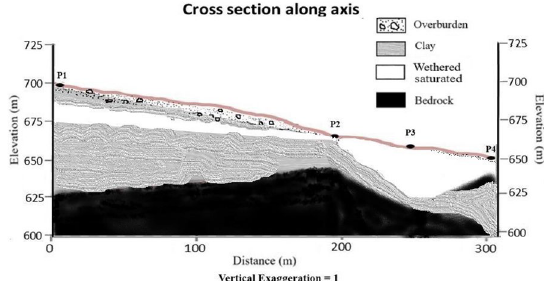
Fig. 8 Interpreted geological profile along survey points P1, P2, P3, and